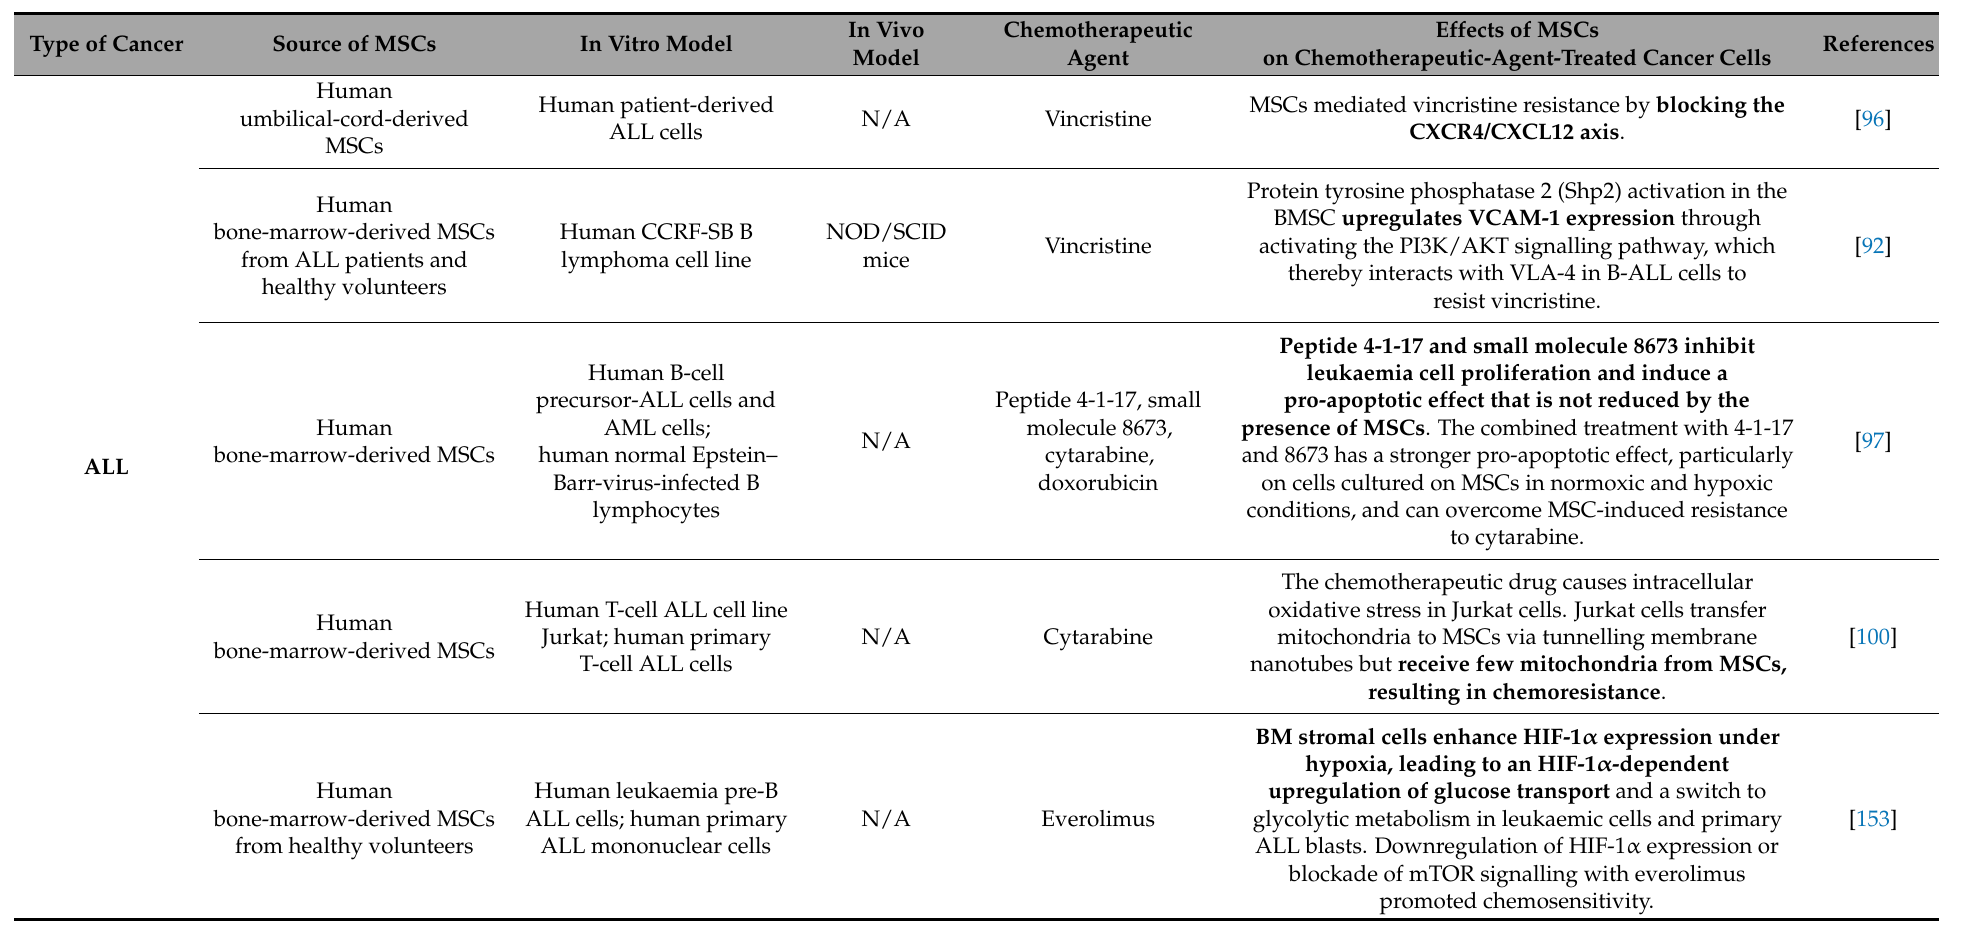
Table 1. Overview of studies investigating the effects of MSCs on chemotherapeutic-agent-treated cancer cells. Bold text indicates the crucial effects of MSCs on chemotherapeutic-agent-treated cancer